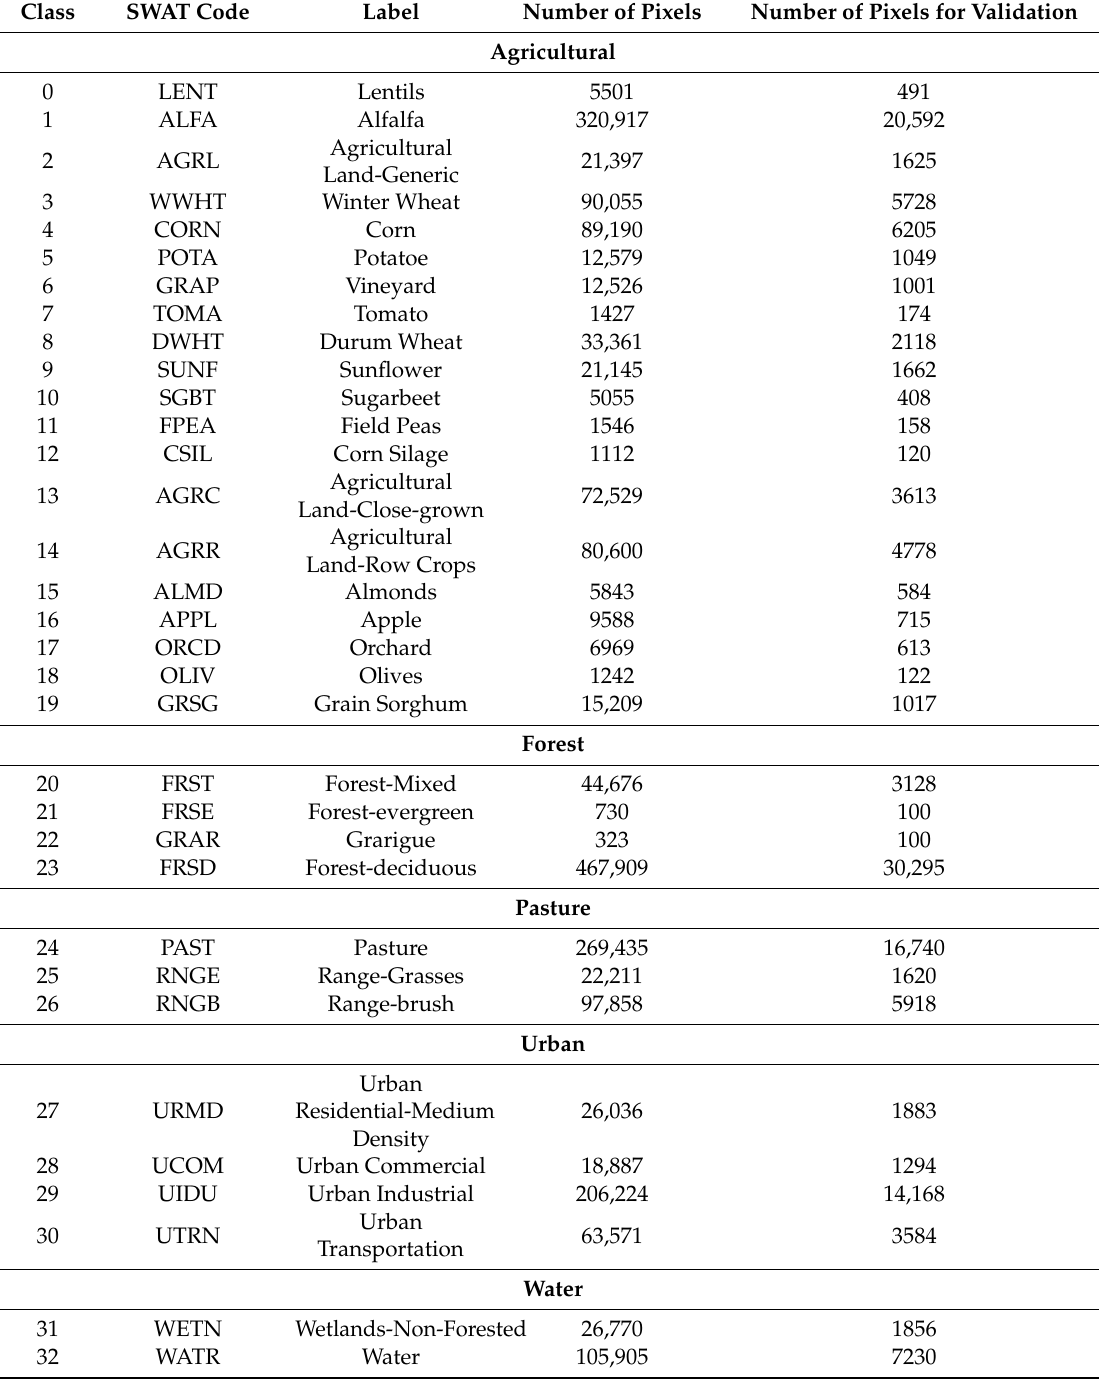
Table A1. Characteristics of the combined reference